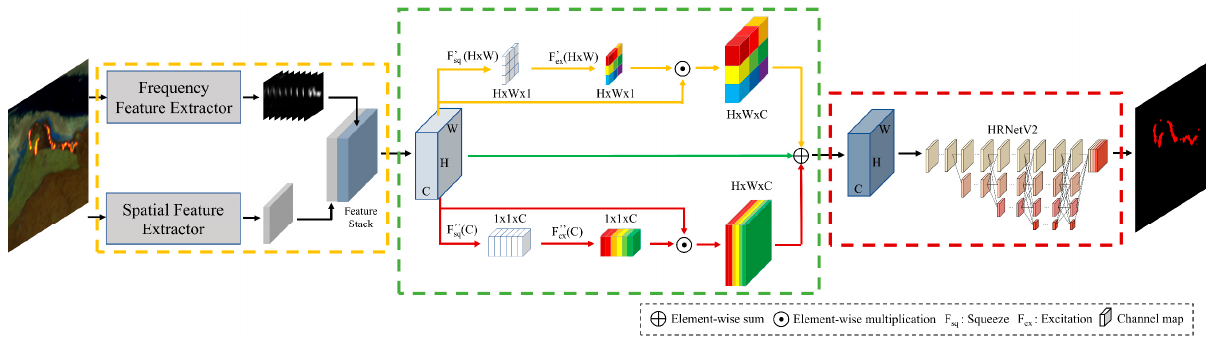
Figure 3. The architecture of the proposed DCPA+HRNetV2 active fire detection